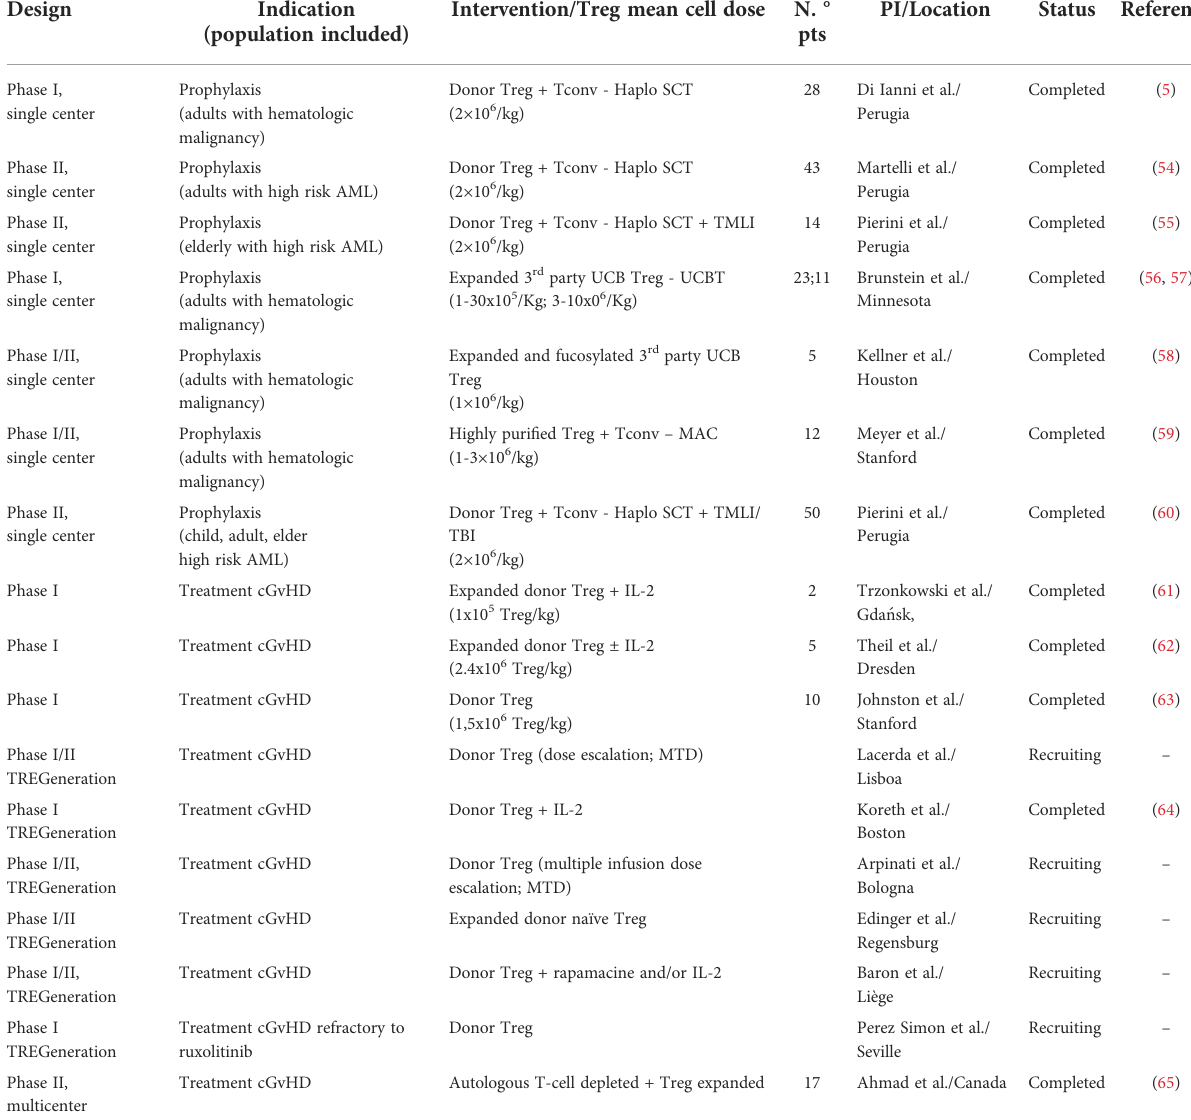
TABLE 1 Principal trials on Treg-cell based therapy in GVHD prophylaxis and treatment.